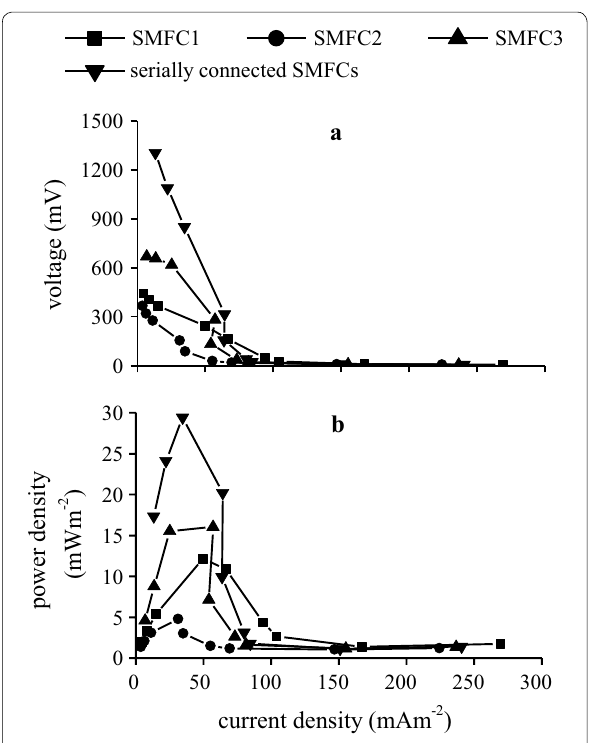
Fig. 3 a Polarization curves and b Power density curves of